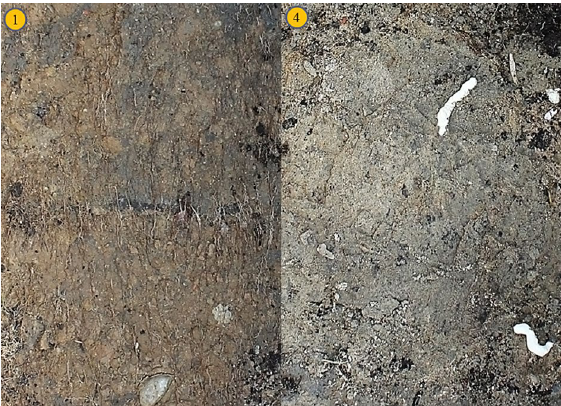
Fig. 16. Root penetration at the unvegetated slope surface. Depending on the subsoil the roots cling into the surface (clay layer, left) or almost not (ash/silt mixture, right). Flume 2, test sections 1 and 4, original unvegetated conditions